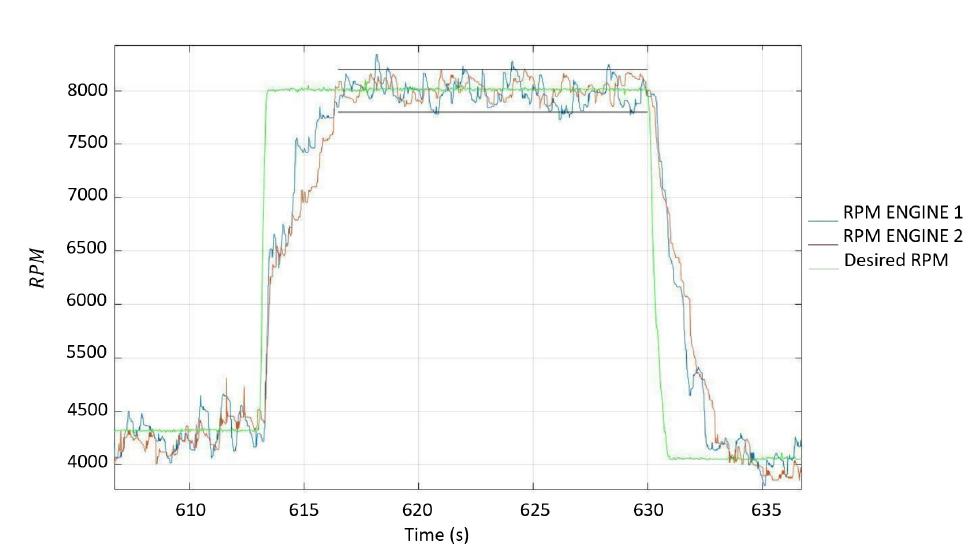
Figure 7. Gasoline engine RPM controller